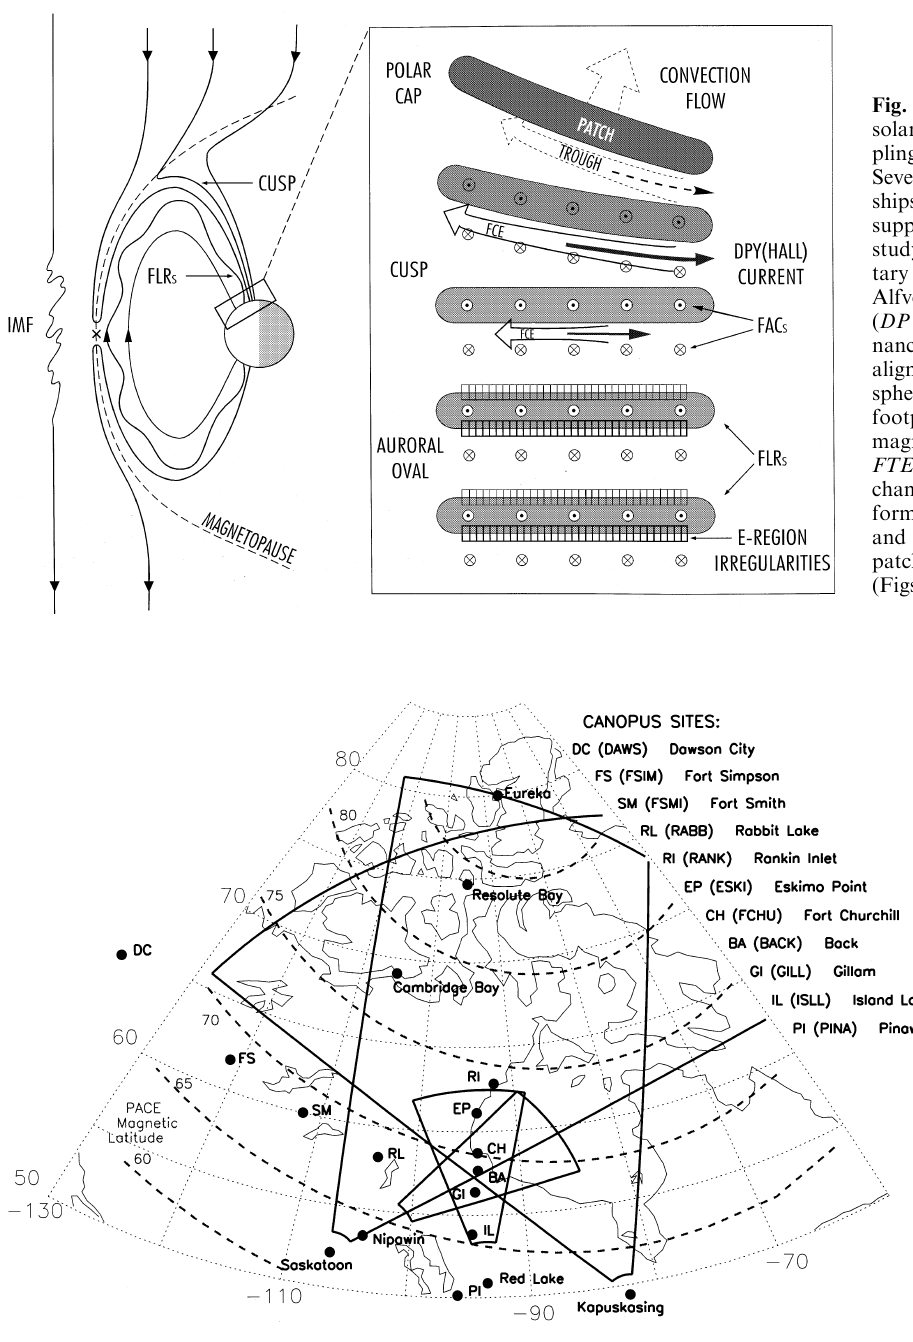
Fig. 2. The locations and fields of view of the SuperDARN Kapuskasing-Saskatoon and BARS Nipawin-Red Lake radars projected onto a map that is also showing some of the CANOPUS and CADI sites. The all-sky imager was located